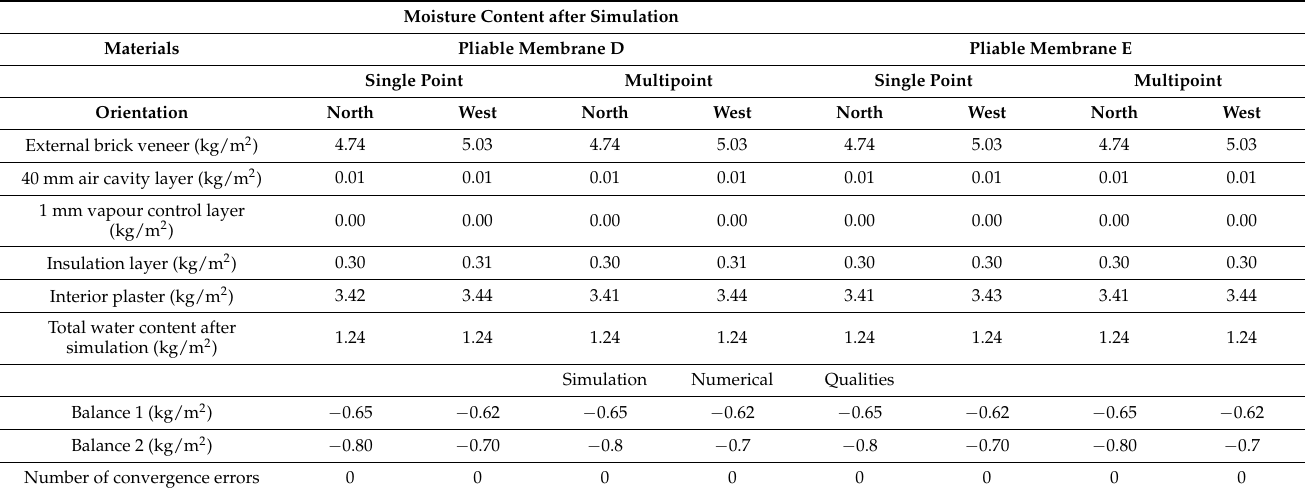
Table A4. Hygrothermal calculation result for Darwin climate on EPW climate file without rain data.